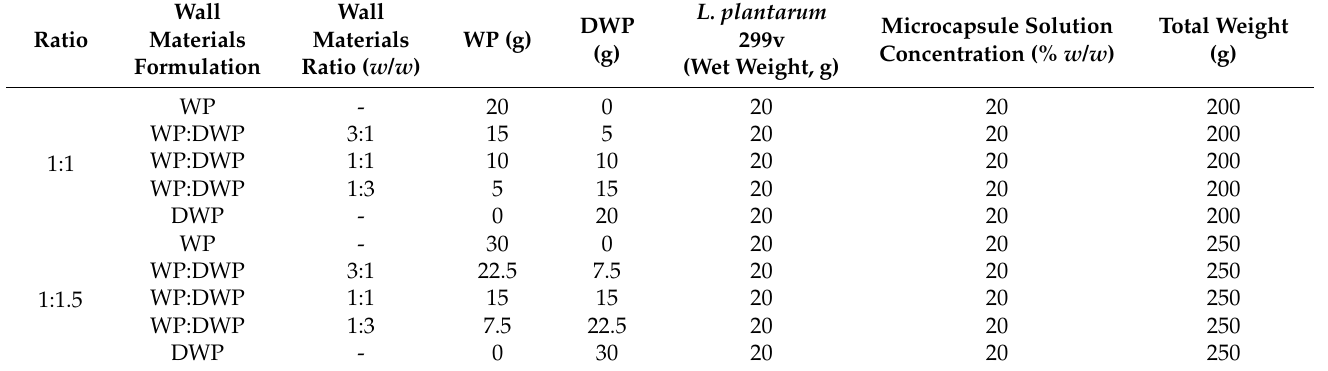
Table 1. Composition of sample solutions for